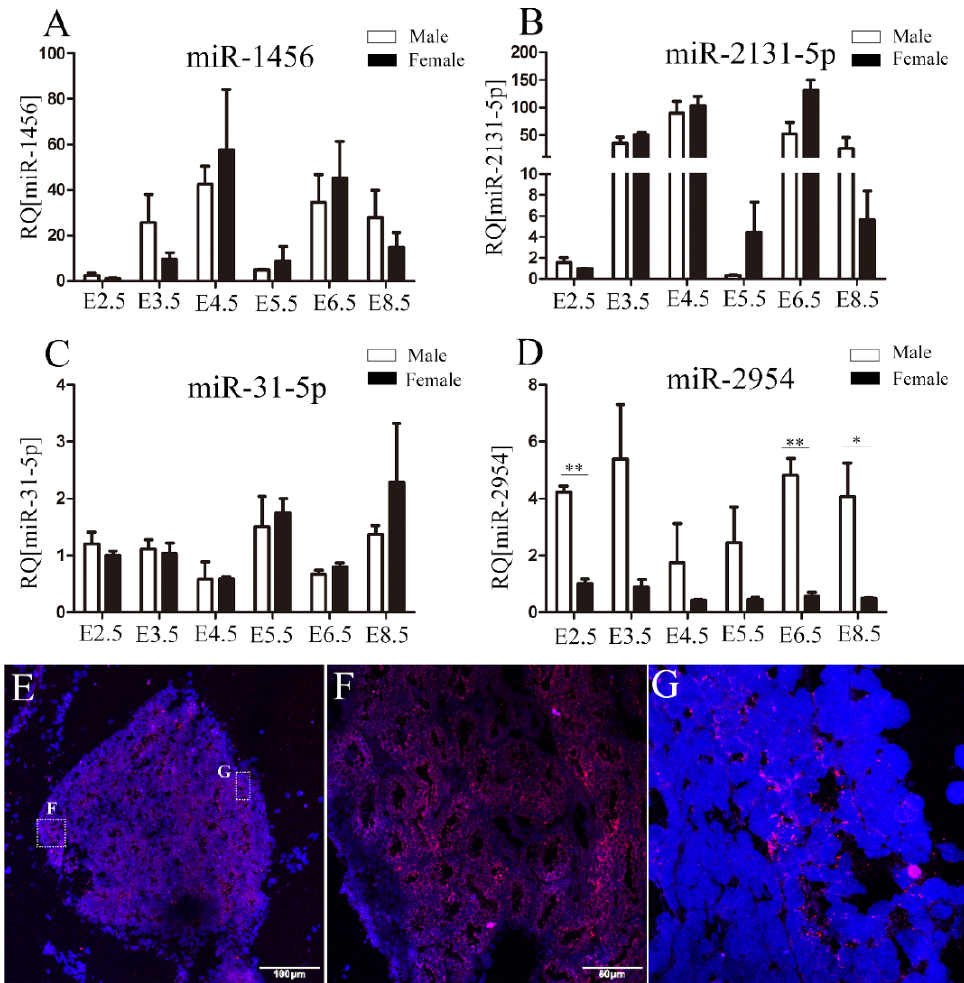
Figure 2. Validation of the expression profiles of miRNAs in chicken embryonic gonads. ( A – D ) The expression profiles of miR-1456, miR-2131-5p, miR-31-5p, and miR-2954 during E2.5–8.5, respectively. Each bar represents the mean and standard error of expression measured by qRT-PCR. Asterisks indicate statistical significance, * p < 0.05, ** p < 0.01. ( E – G ) The localization of miR-2954 expression in chicken embryonic testis at E10. DAPI staining of nuclei is blue and immunofluorescence of miR-2954 is red. E, scale bar = 100 μ m; F, scale bar = 50 μ m, thickness = 10 μ m; G, magnification = 100.